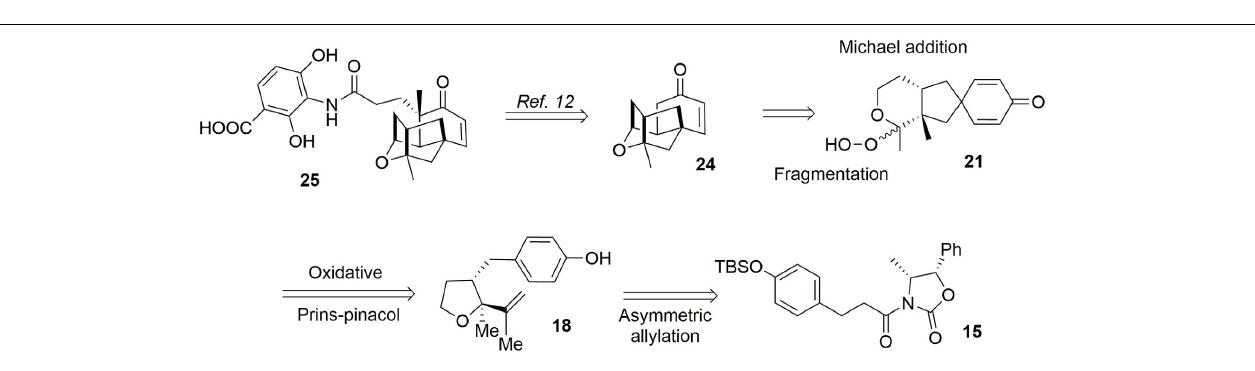
FIGURE 4 | Retrosynthesis of ( − )-platensimycin main